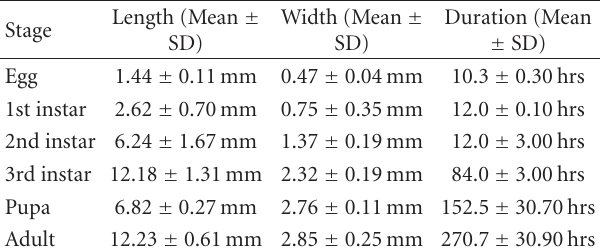
Table 1: Size and life span (Mean ± SD) of each developmental stage of Hemipyrellia ligurriens under natural ambient conditions (26.7 ± 0.61 ◦ C, 74 ± 3% RH) of Phitsanulok province, northern